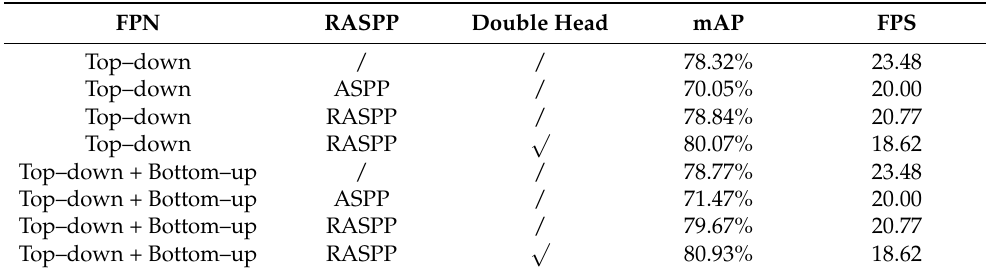
Table 4. The results of DPN-Detector with different components on the NEU-DET dataset. ( this module, /: not use this